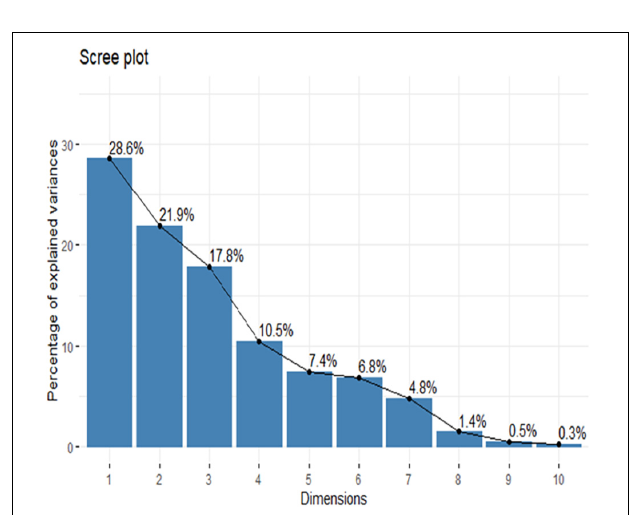
FIGURE 5 | Cumulative variance scree plot of ten extracted principal components.